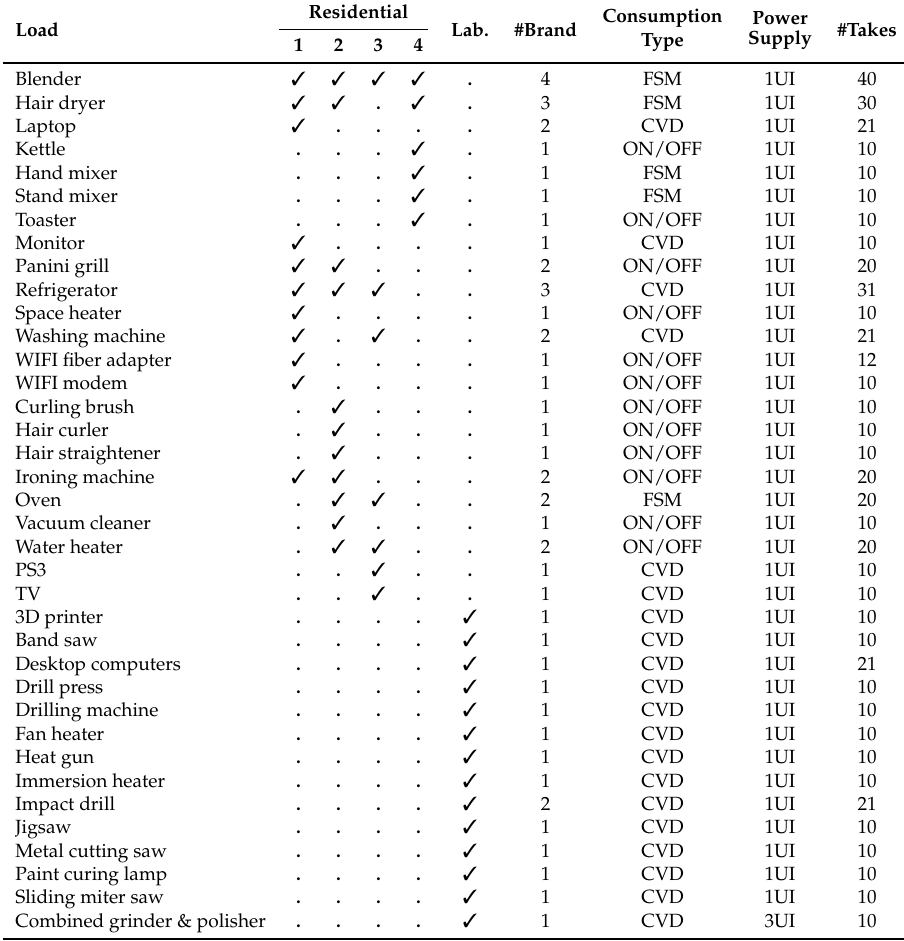
Sampling rate (S/s) 1/10 Total duration (days) Table 5. Summary of monitored loads for IL signature data in MORED. Residential Load Lab. Blender